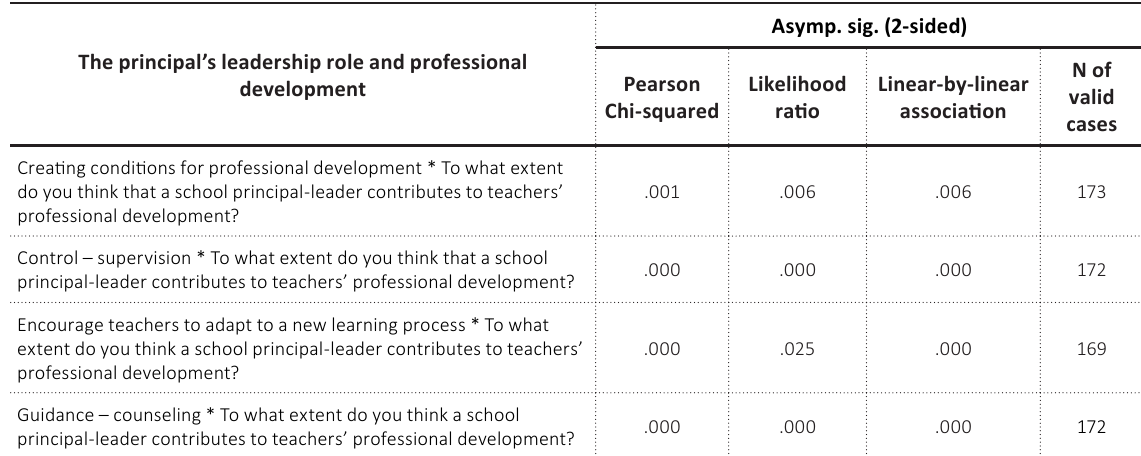
Table 5. Chi-squared analysis for hypothesis H